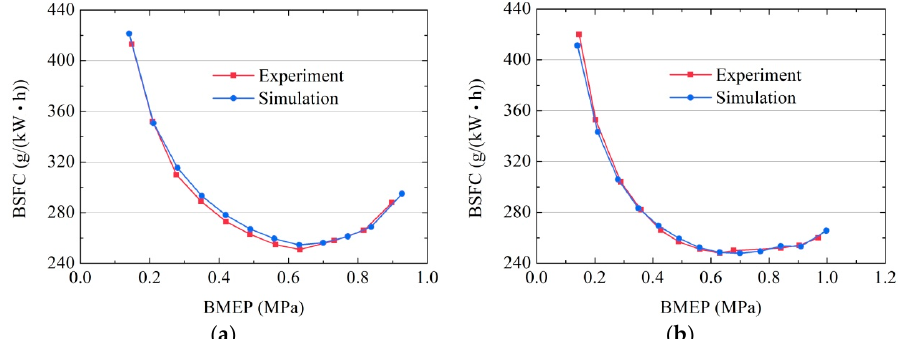
Figure 8. Comparisons of simulation results and experimental results at 1200 rpm and 1600 rpm: ( a ) 1200 rpm; ( b ) 1600 rpm.